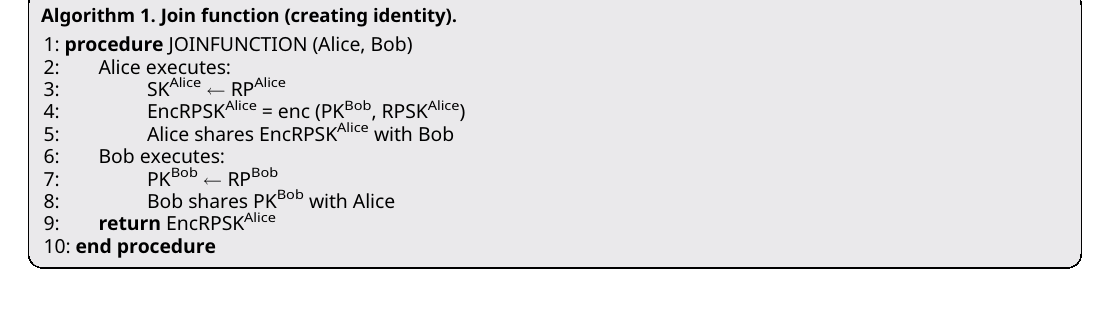
Algorithm 2. Content authentication against